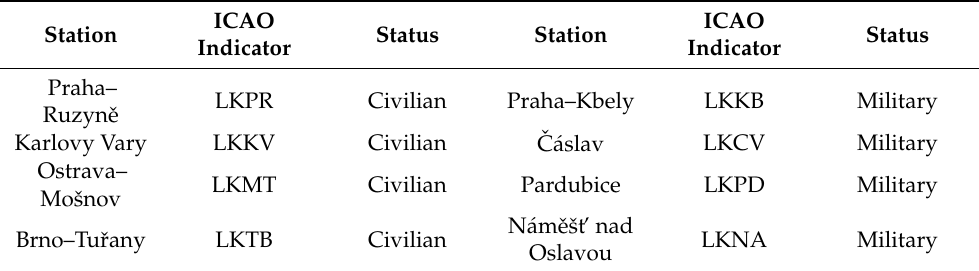
Table 1. List of stations. ICAO, International Civil Aviation